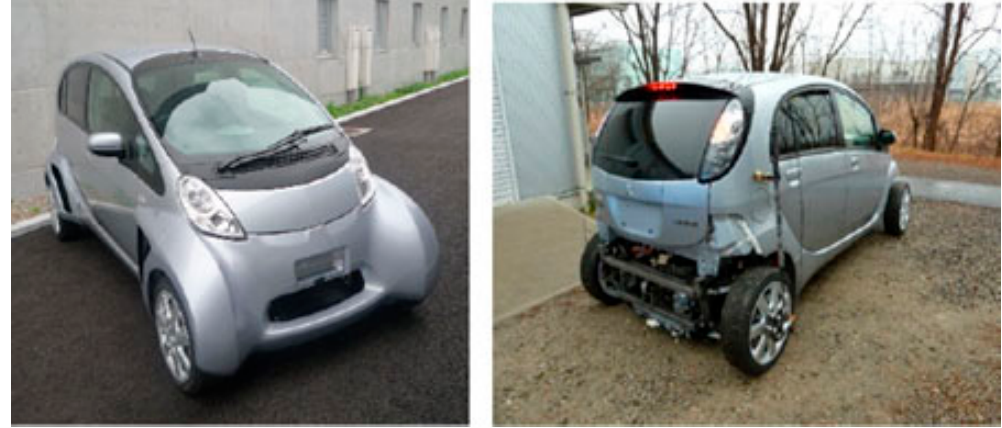
Figure 15. Experimental vehicle with W-IWM system by Sato et al. [26]. (Reprint with permission [26]; 2015, IEEE.)